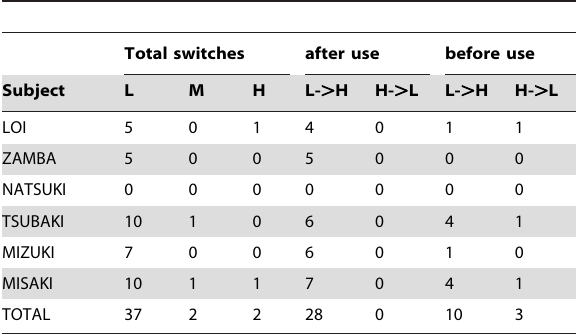
Table 9. Number of total switches observed as a function of hammer weight (L =300 g, M=600 g, H=1200 g) and the direction of switches (L- . H=from lighter to heavier; H- . L=from heavier to lighter) in Experiment